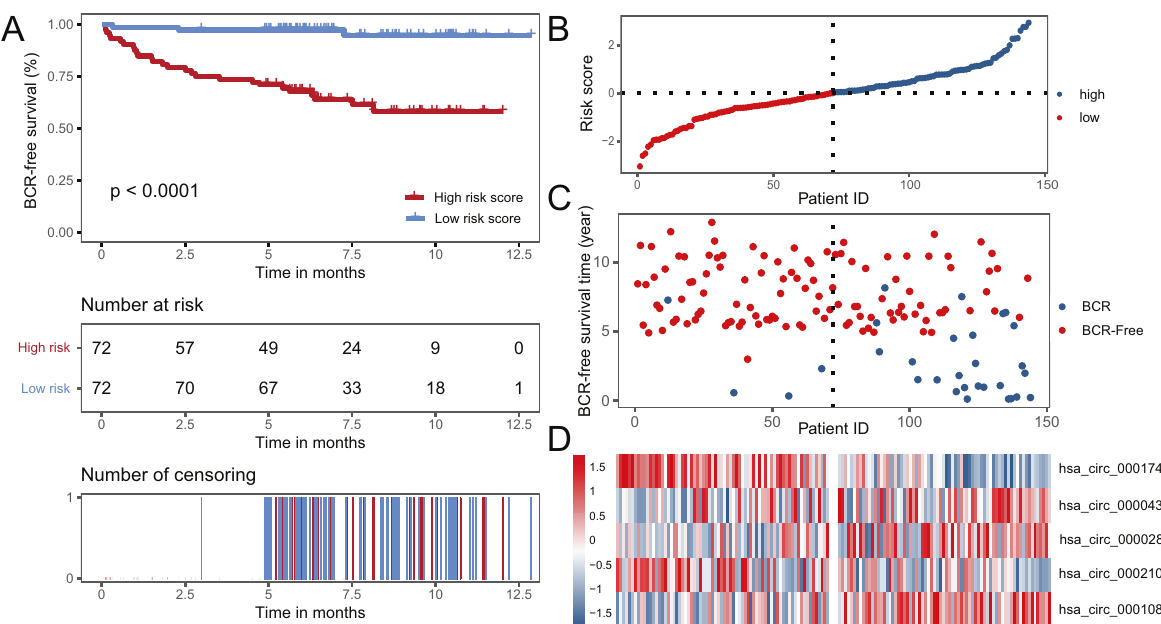
Fig. 3 Construction and validation of autophagy-related circRNA signature in PCa patients. A KM survival curve analysis shows that BCR- free survival time of patients with high-risk scores is signi fi cantly shorter than those with low-risk scores. B Distribution of risk scores of high- and low-risk patients with PCa. C Scatterplot shows the correlation between survival time and risk score of patients with PCa. D Heatmap shows that high-risk patients displayed higher level of risk factors (hsa_circ_0000437, hsa_circ_0000280, and circ_5017), whereas low-risk patients displayed higher level of protective factors (hsa_circ_0001747 and